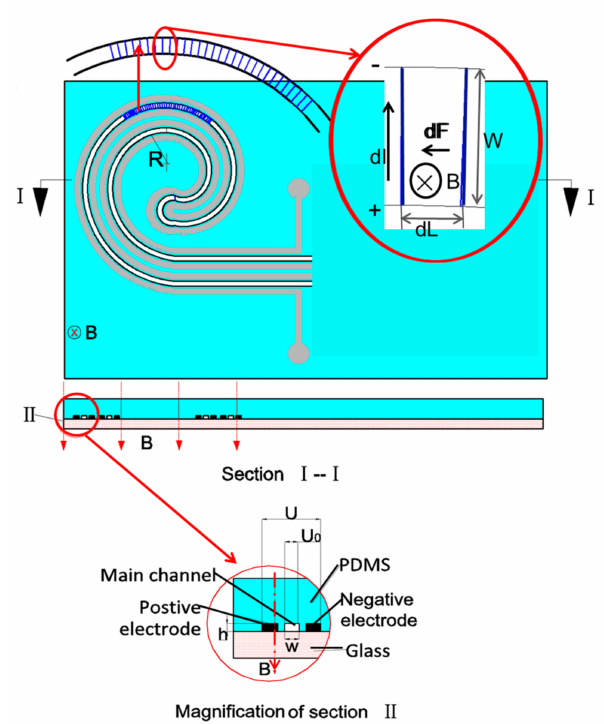
Figure 2. Working principles of the liquid-metal-based MHD